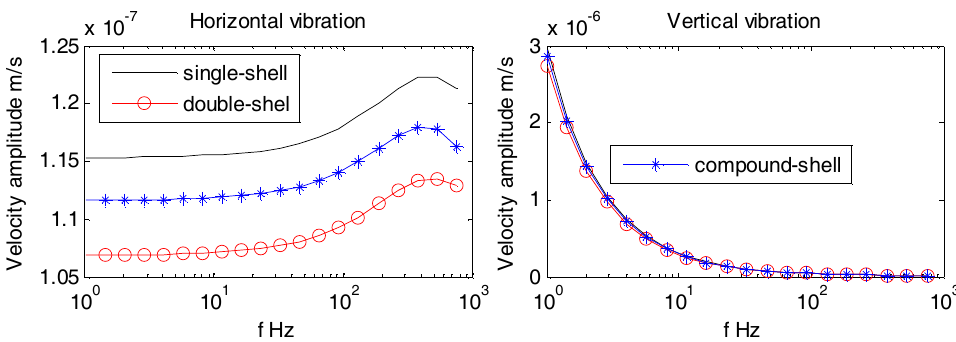
Figure 30. Vibration velocity amplitudes of the OBSs with various casings under incident angle of 10°.